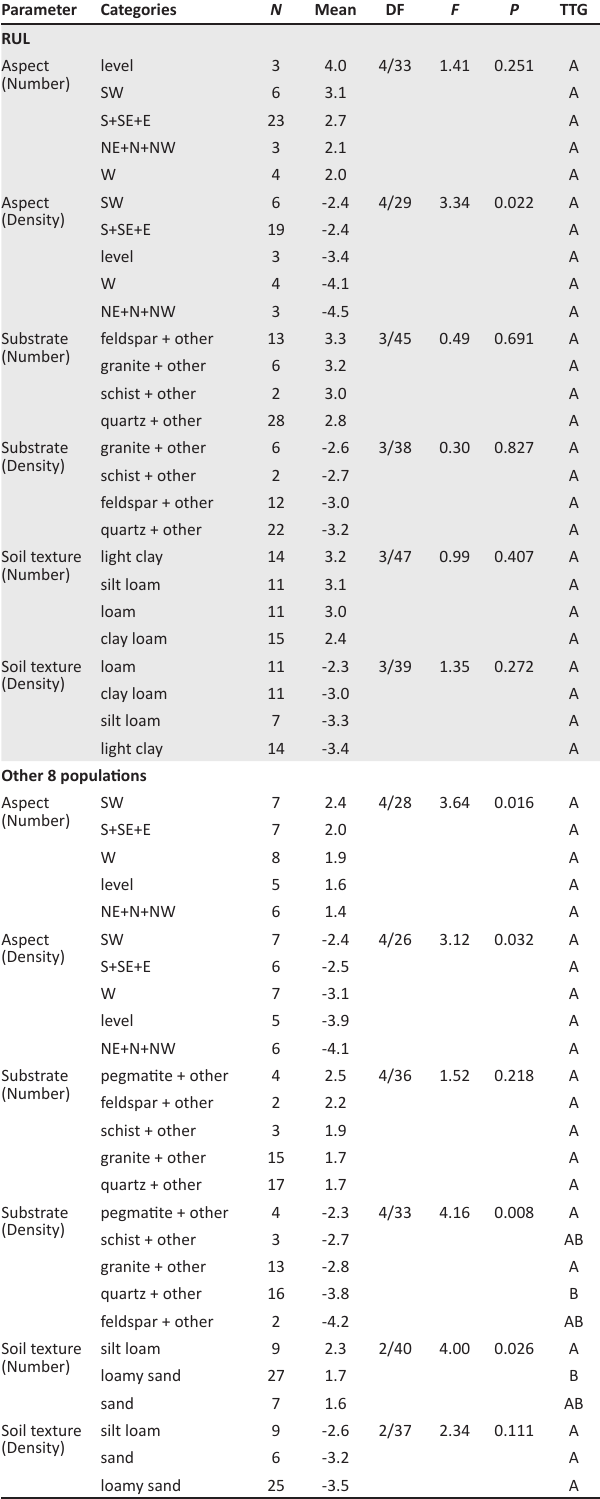
TABLE 2-A1: Details of ANOVAs performed to investigate the effect of aspect, substrate and soil texture on plant number and density at RUL and the other 8 populations, accompanied by Tukey test grouping (TTG): entries with identical letters do not differ at P < 0.05. Mean values are based on natural logarithm